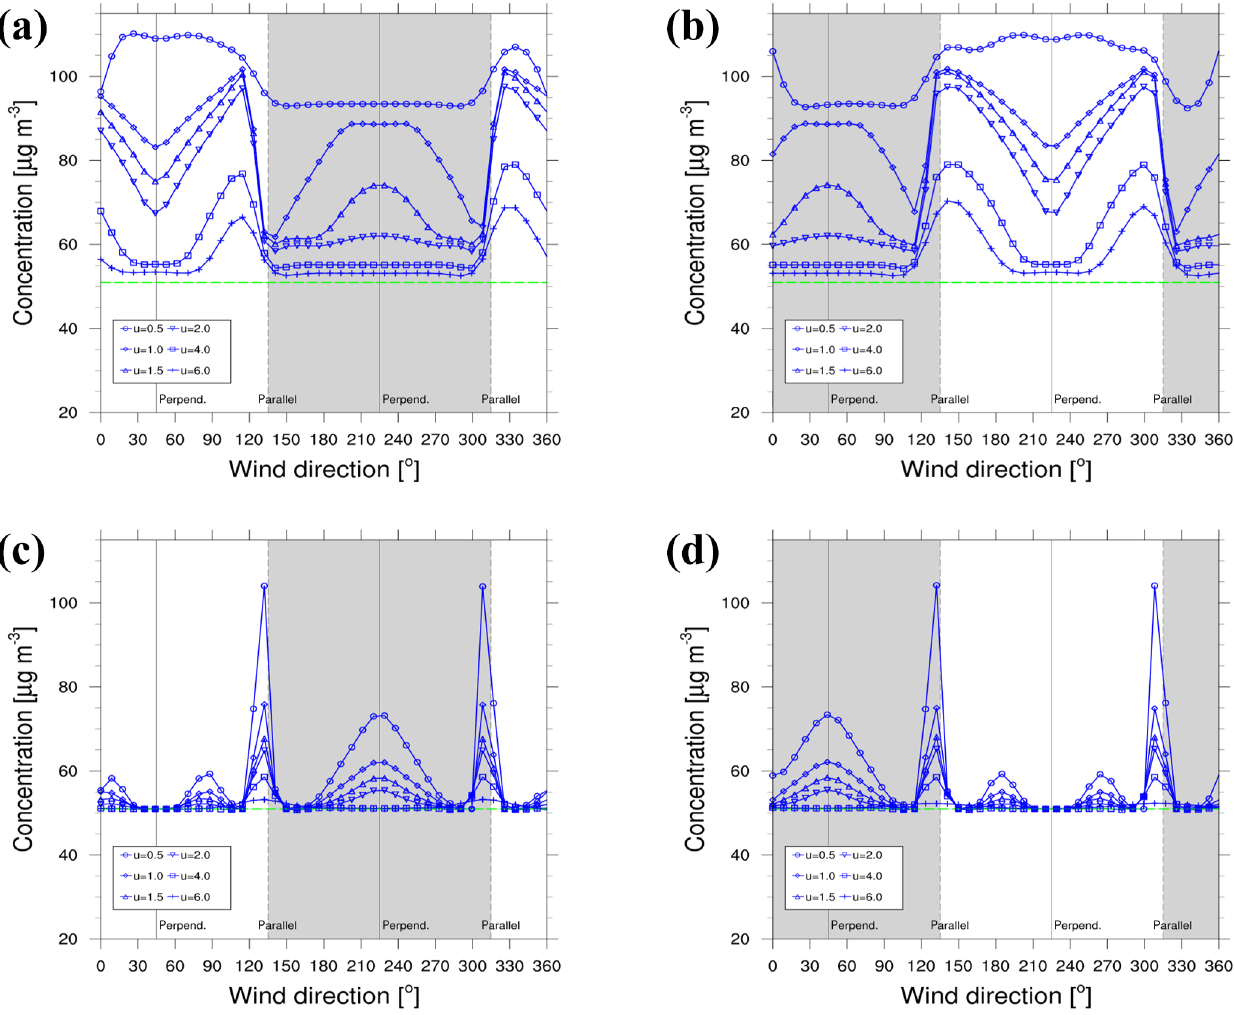
Figure 5. Test of the street canyon model: concentration of an inert tracer (PM 10 ) at the northeast side receptor (a, c) and at the southwest side receptor (b, d) as a function of wind direction and wind speed (a, b) from a simulation with SSCM and (c, d) from a simulation with HIWAY-2 (no street canyon). The background concentration, taken from the grid cell at a maximum distance from the line, is shown as a green line. Wind speed (ms − 1 ) is given in the legend. Grey-shaded area indicates when the station is on the windward side of the street canyon. The solid vertical line indicates wind perpendicular to the street, and the dashed vertical line indicates wind parallel to the